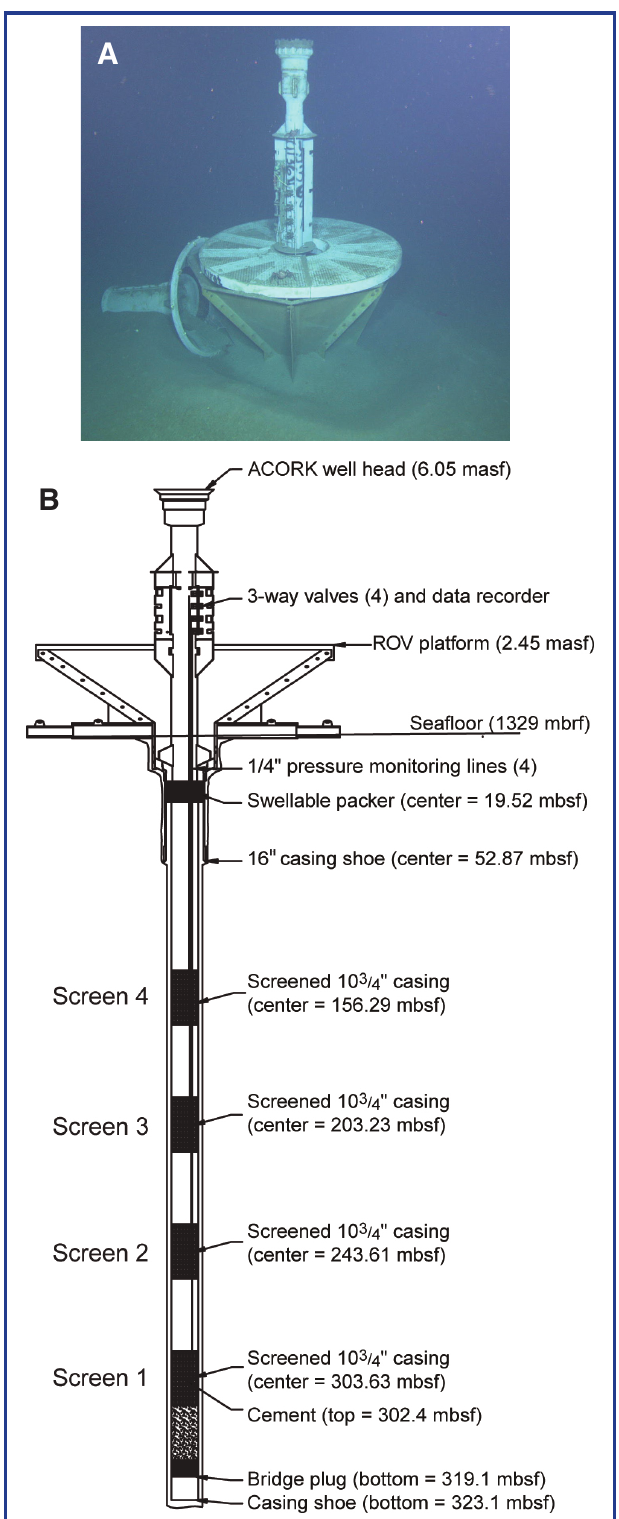
Figure 3. [A] The photograph of the reentry cone and ACORK wellhead (inset) was taken during the July NEPTUNE Canada servicing trip by the ROV ROPOS. The secondary cone seen lying on the seafloor to the left of the wellhead was intended to guide reentry into the casing for the bridge plug and cement installation, but it failed to land properly. Reentry was accomplished through the 24-inch diameter of the uppermost part of the ACORK structure. [B] Schematic illustration of the ACORK system installed in Hole U1364A, with component depths given in meters above and below seafloor (masf,